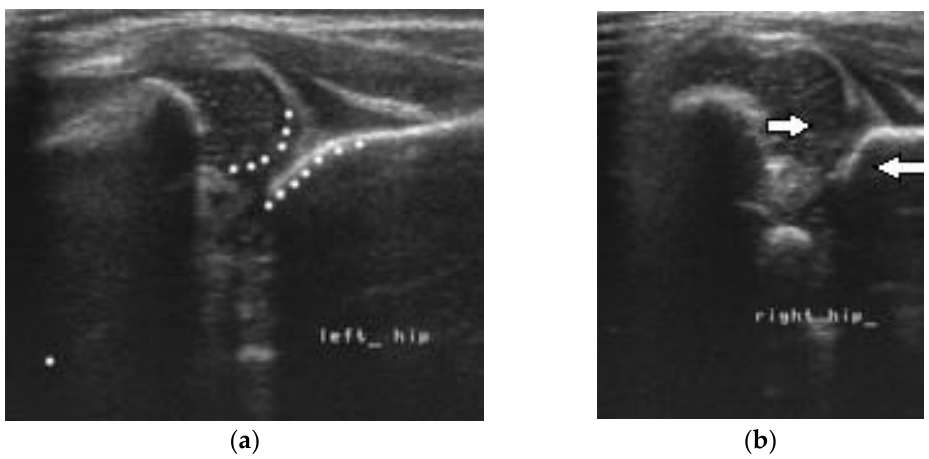
Figure 4. Bilateral DDH with disruption of the double concentric sign on the left and right side. ( a ) The acetabulum is elliptic and the head has a spherical shape ( b ) The arrows point to the femoral head and the sloping acetabulum. There is increased distance between the head and the depth of the acetabulum.